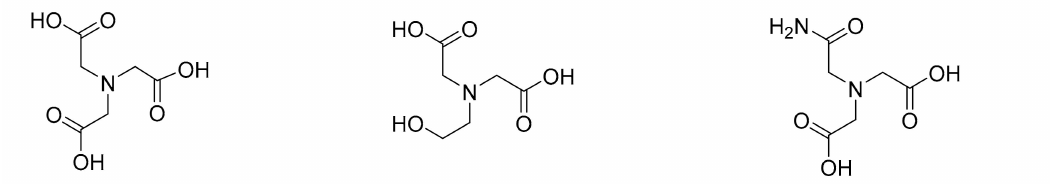
Figure 10. The structure of the three